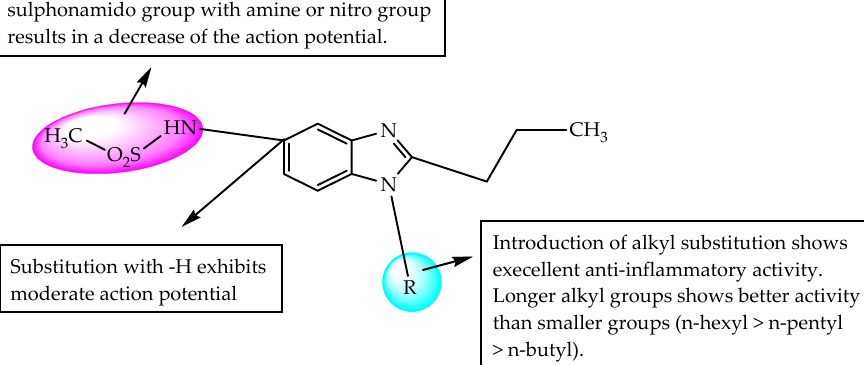
Figure 50. SARs of methanesulphonamido-benzimidazoles.